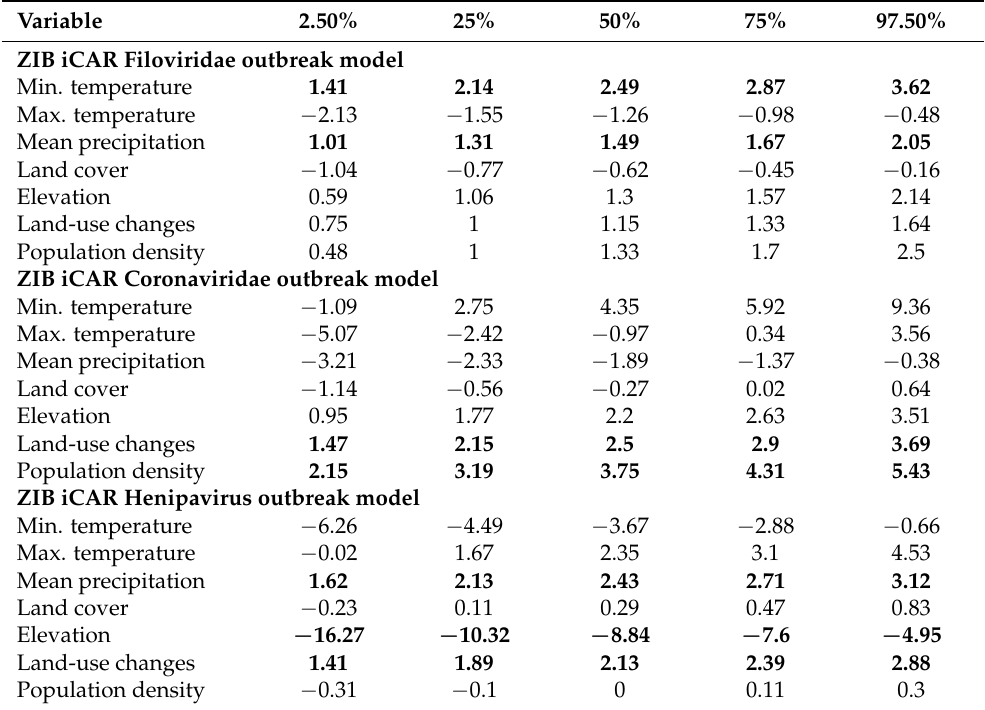
Table 2. Quantiles for each variable contributing to the ZIB iCAR model predictions. The significant variables are shown in